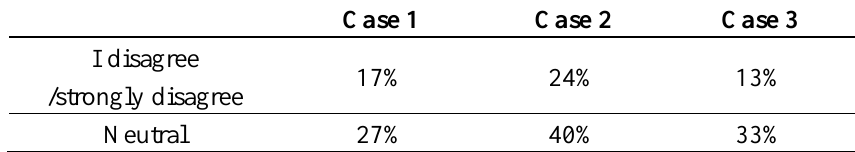
Table 4. Performance metrics do not support reflective